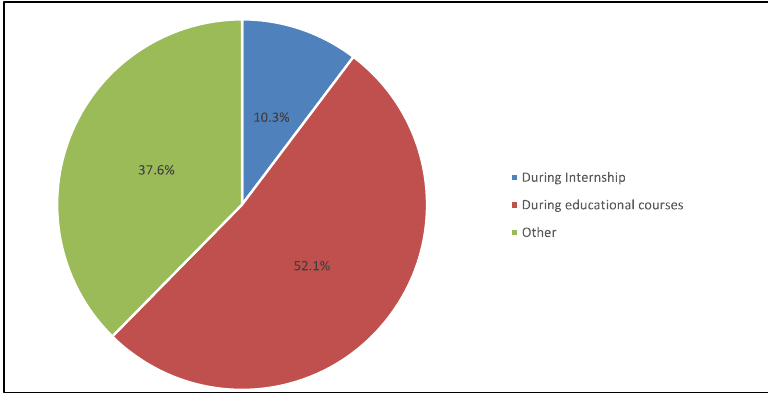
MID training during their internship (Figure 2). Figure 1. Respondents ‘distribution according to students’ academic year level in relation to gender.